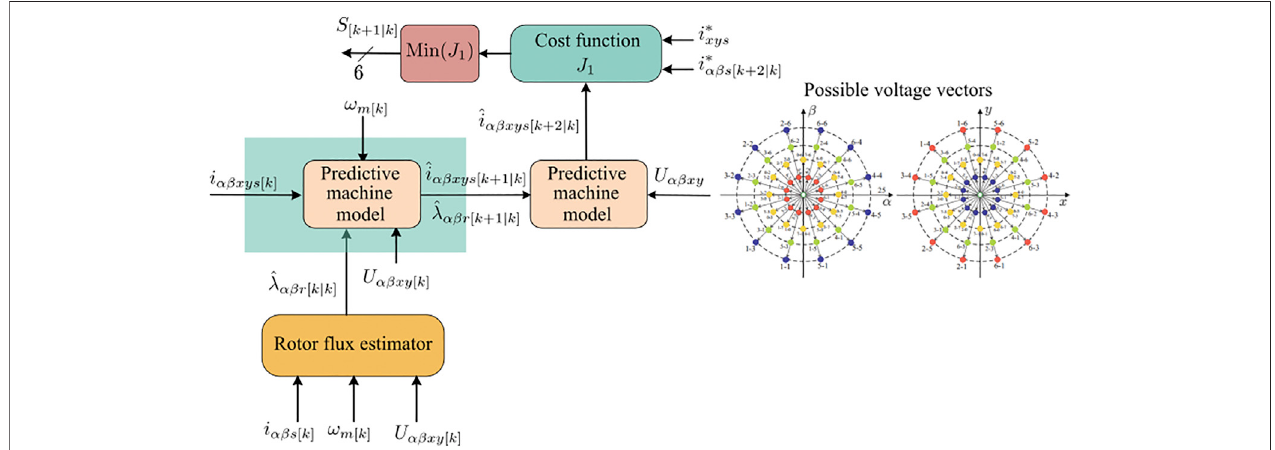
FIGURE 9 | Addition of a full-order rotor fl ux observer in a MPC scheme for asymmetrical six-phase IM fed by two Voltage Source Inverters (VSIs).